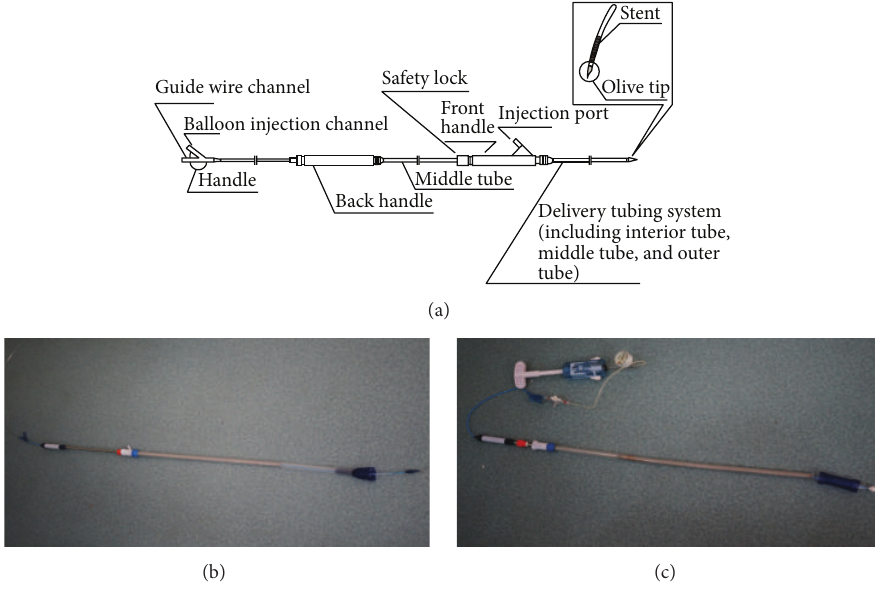
Figure 2: The stent delivery system. (a) The schematic diagram of the stent delivery system. The delivery system consists of three coaxial tubes. The outer tube serves to constrain the stent until being retracted during the stent deployment. The interior tube contains a central lumen that accommodates a 0.035 in./0.89 mm guide wire. In addition, the delivery system has a balloon catheter. (b) A stent was partly accommodated into a delivery system. The outer tube was 22 Fr. A 0.035-inch guide wire was inserted into the interior tube. (c) The balloon catheter was designed at 28 × 100mm size; the balloon and a pump for balloon dilation were showed.